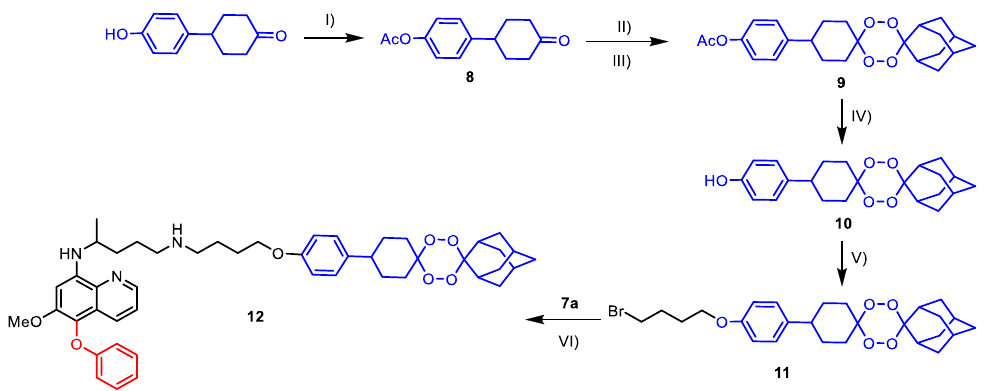
Figure 4. Synthesis of 5-phenoxy primaquine-tetraoxane hybrid ( 12 ); reagents and conditions: (I) acetic anhydride (3.0 equiv.), Et 3 N (2.0 equiv.), DCM, 0 ◦ C to r.t., (quant.); (II) 30% H 2 O 2 , HCO 2 H/MeCN, 0 ◦ C to r.t.; (III) 2-adamantanone (1.0 equiv.), 5 mol% Bi(OTf) 3 , DCM, r.t., (22% over 2 steps); (IV) LiOH · H 2 O (3.0 equiv.), THF, water, r.t., 3 h, (92%); (V) 1,4-dibromobutane (3.0 equiv.), K 2 CO 3 (4.0 equiv.), MeCN, 60 ◦ C, 6 h, (73%); (VI) K 2 CO 3 (1.0 equiv.), KI (0.2 equiv.), anh. DMF, r.t., (51%).